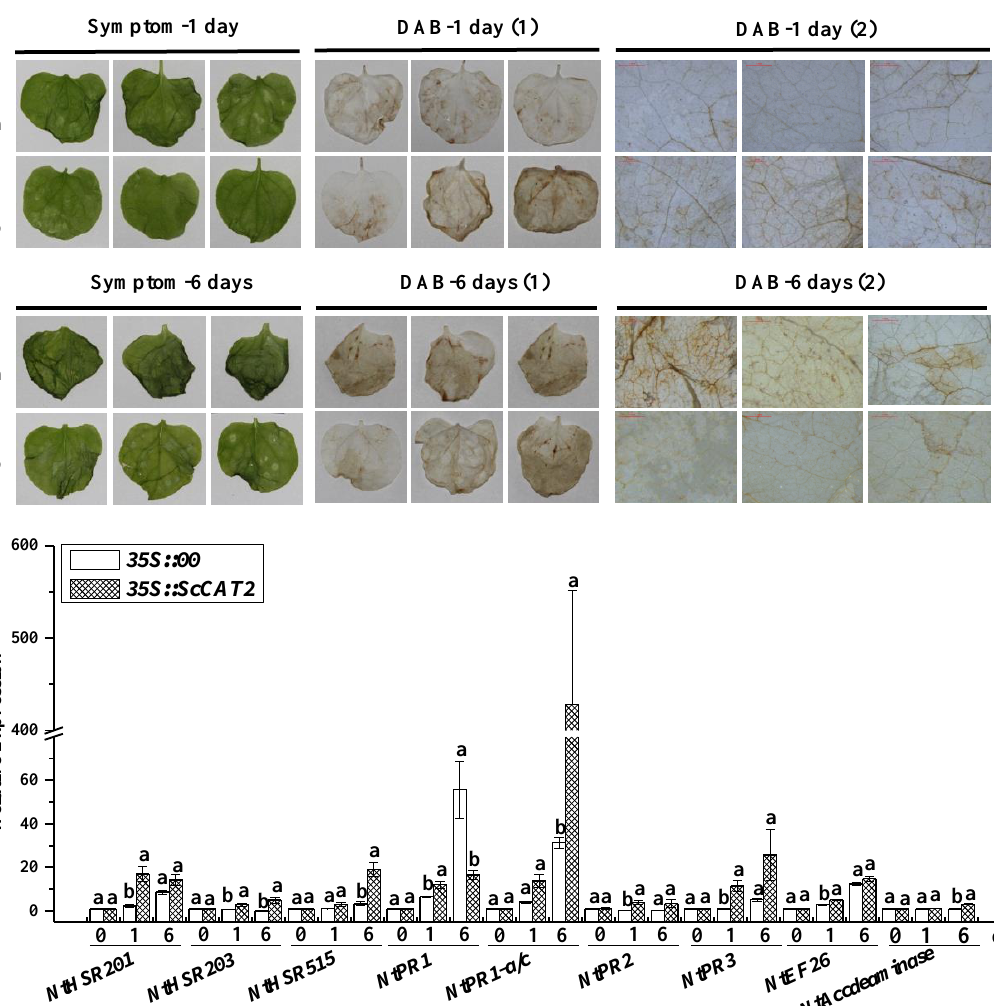
Figure 11. The effect of transient overexpression of ScCAT2 in Nicotiana benthamiana leaves after inoculation with Fusarium solani var. coeruleum . ( A ) The disease symptoms and DAB staining of N. benthamiana leaves 1 day and 6 days after inoculation with F. solani var. coeruleum . ( B ) Analysis of the nine tobacco immune-related marker genes in the N. benthamiana leaves after inoculation with F. solani var. coeruleum for 1 day and 6 days, respectively. The tobacco immune-related marker genes included the hypersensitive response marker genes NtHSR201 , NtHSR203 , and NtHSR515 ; the salicylic acid-related genes NtPR-1 and NtPR-1a/c ; the jasmonic acid pathway-associated genes NtPR2 and NtPR3 ; and the ethylene synthesis-dependent genes NtEFE26 and NtAccdeaminase , and using NtEF1- α for data normalization. All data points were means ± standard error ( n = 3). Different lowercase letters indicated a significant difference, as determined with Duncan’s test ( p < 0.05). The empty vector 35S::00 and recombinant vector 35S::ScCAT2 were indicated by a and b, respectively. (1) and (2) represented images captured using a SONY camera and microscope, respectively. Bar = 1 mm.